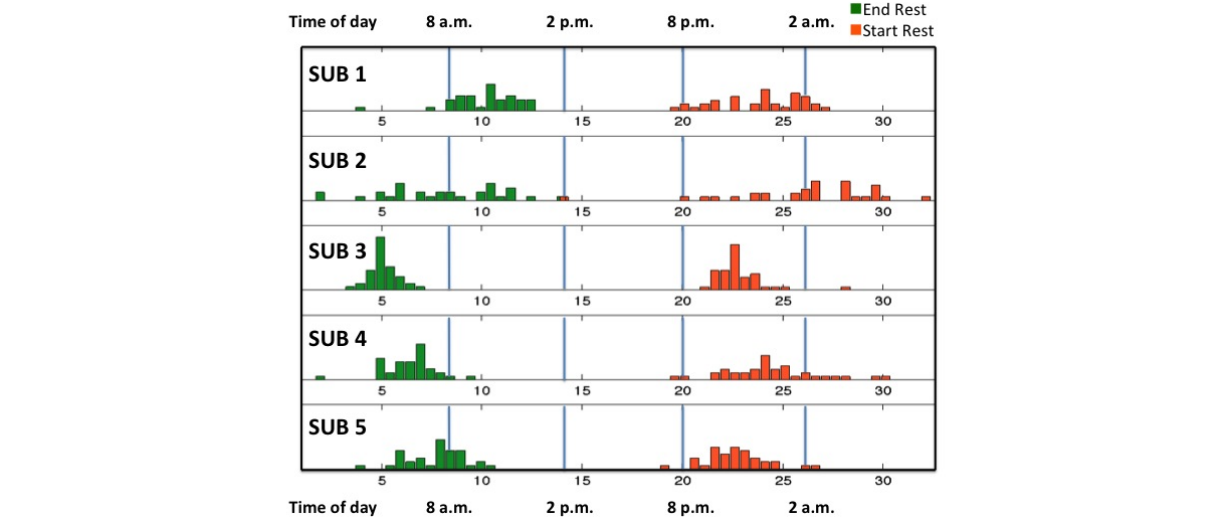
Figure 6. Frequency distribution of the estimated sleep and wake times of